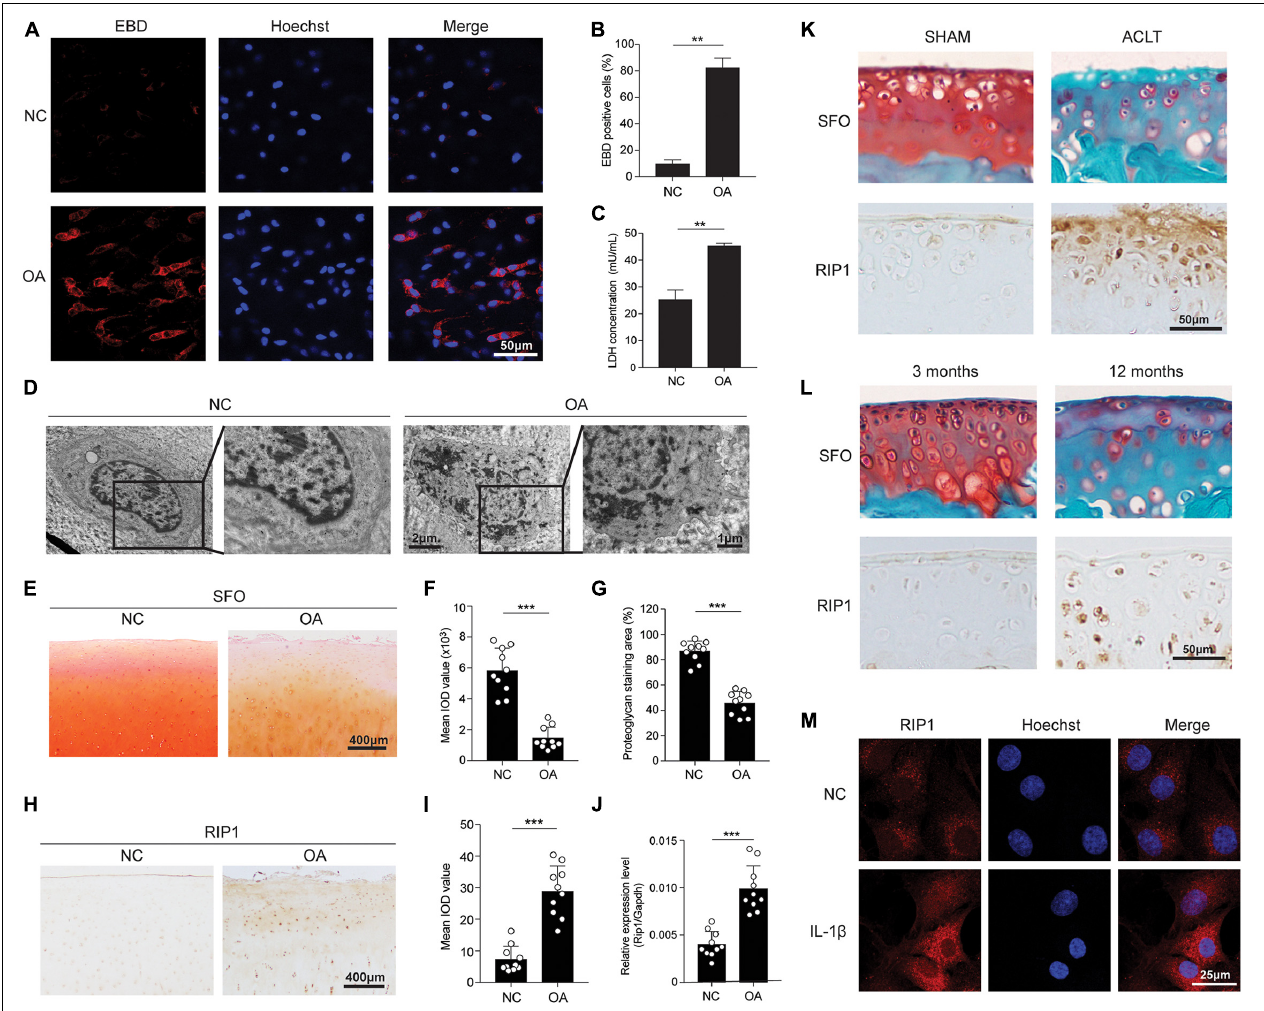
FIGURE 1 | Chondrocyte necrosis and RIP1 upregulation are both presented in OA cartilage tissues. (A,B) Representative photomicrographs (A) and quantitative data (B) of chondral EBD uptake (red) in healthy and OA human cartilage ( n = 6 for each group). Cell nuclei were labeled by Hoechst. (C) LDH concentrations in the cultural supernatant of healthy and OA human cartilage explants cultured ex vivo for 10 days ( n = 5 for each group). (D) Representative TEM images of healthy and OA human cartilage. (E) Safranin O staining of healthy and OA human cartilage ( n = 10 for each group). (F,G) The integrated optical density (IOD) value (F) and positive staining area (%) (G) of proteoglycan content in healthy and OA human cartilage tissues determined by safranin O staining ( n = 10 for each group). (H) RIP1 immunostaining of healthy and OA human cartilage ( n = 10 for each group). (I) The IOD value of RIP1 immunostaining in healthy and OA human cartilage tissues ( n = 10 for each group). (J) The mRNA level of RIP1 in primary chondrocytes derived from healthy and OA human cartilage tissues measured by qRT-PCR ( n = 10 for each group). (K) Safranin O staining and RIP1 immunostaining of cartilage from sham- and ACLT-operated rats ( n = 10 for each group). (L) Safranin O staining and RIP1 immunostaining of cartilage from 3- and 12-month old rats ( n = 10 for each group). (M) RIP1 immunofluorescent staining of rat chondrocytes treated with or without 10 ng/mL IL-1 β for 24 h ( n = 3 for each group; three independent experiments). ** P < 0.01 and *** P <